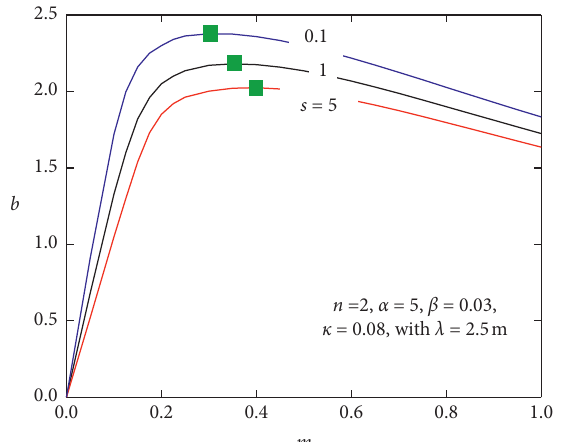
Figure 4: Dependence of the dimensionless buckling load b on the tapered ratio m , for different friction ratios s .